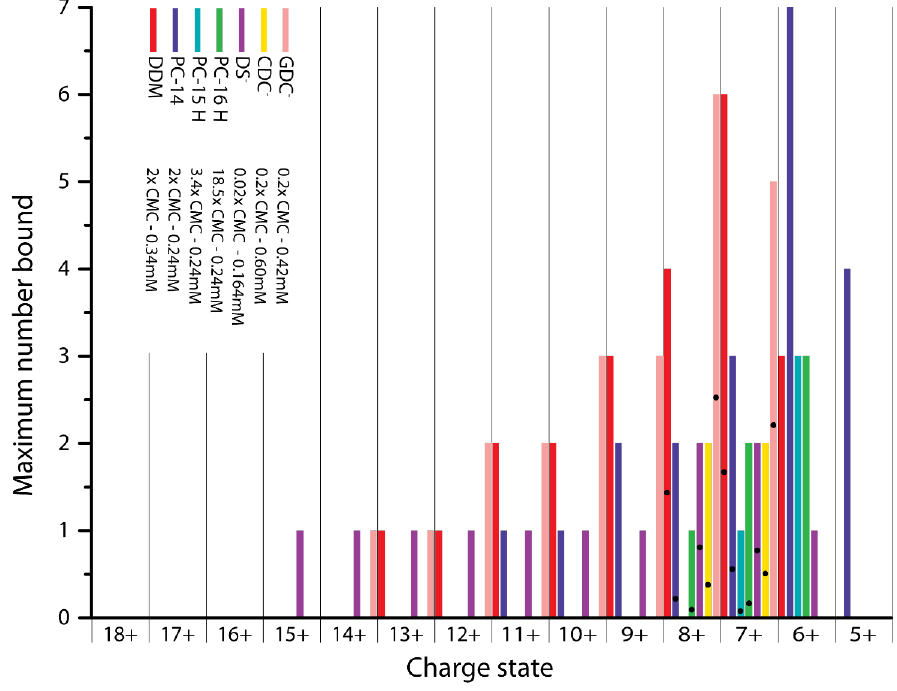
Figure 2. Comparison of the number of detergent molecules bound per charge state per detergent (DDM 2x CMC, PC-14 2 × CMC, PC-15 3.4 × CMC, PC-16 18.5 × CMC, SDS 0.02 × CMC, SCDC 0.2 × CMC and SGDC 0.2 × CMC). PC-15, PC-16 and CDC - only bind to lower (compact) charge states while DDM, PC-14, DS - and GDC - also interact with higher (extended) charge states. The average number of molecules bound per detergent for the 7 + and 8 + charge state is indicated by dots.